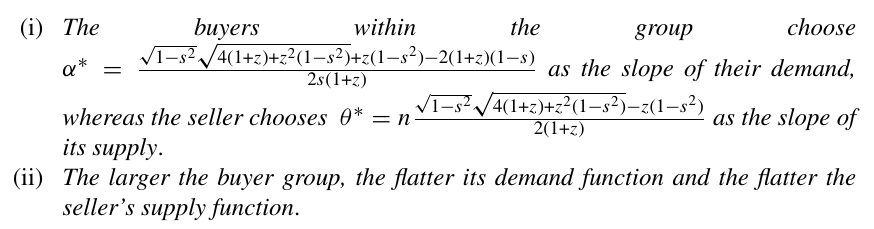
From Eqs. (13) and (15) it follows that Ψ (cid:6)